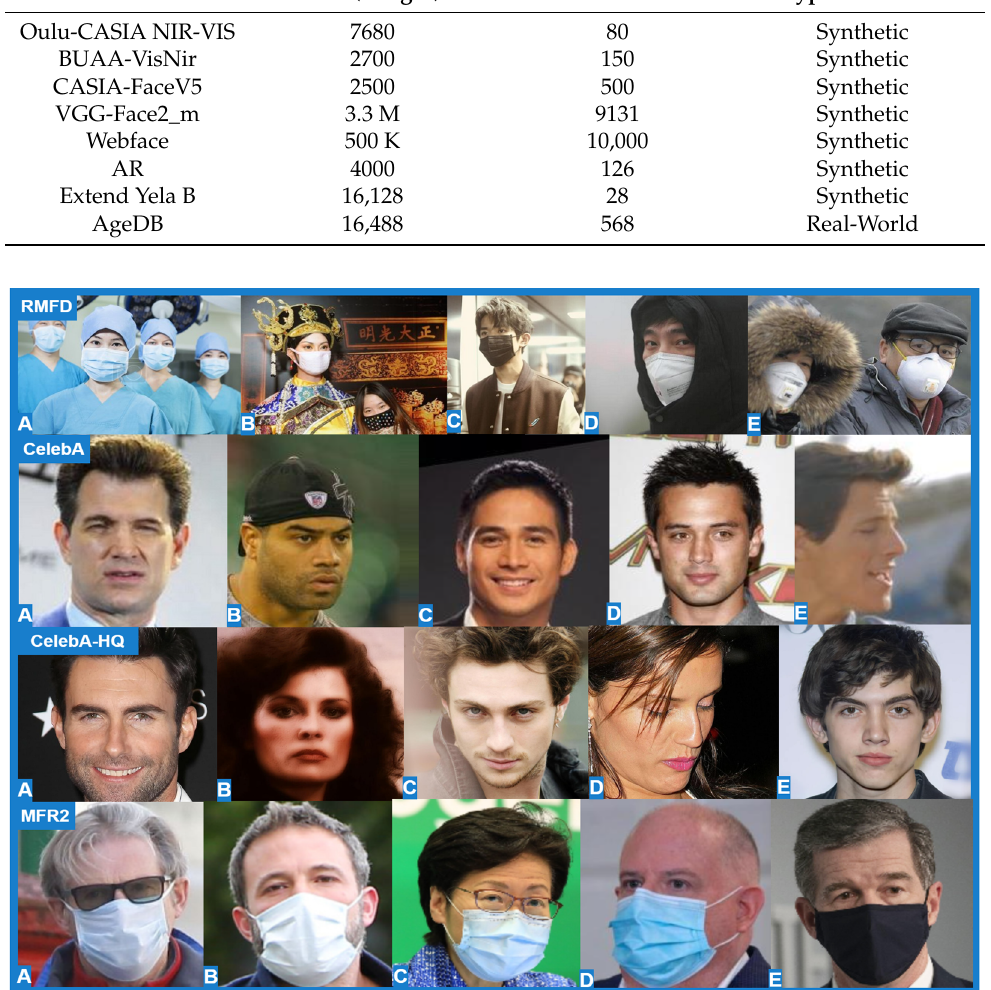
Figure 4. Sample images from publicly available benchmarking datasets.